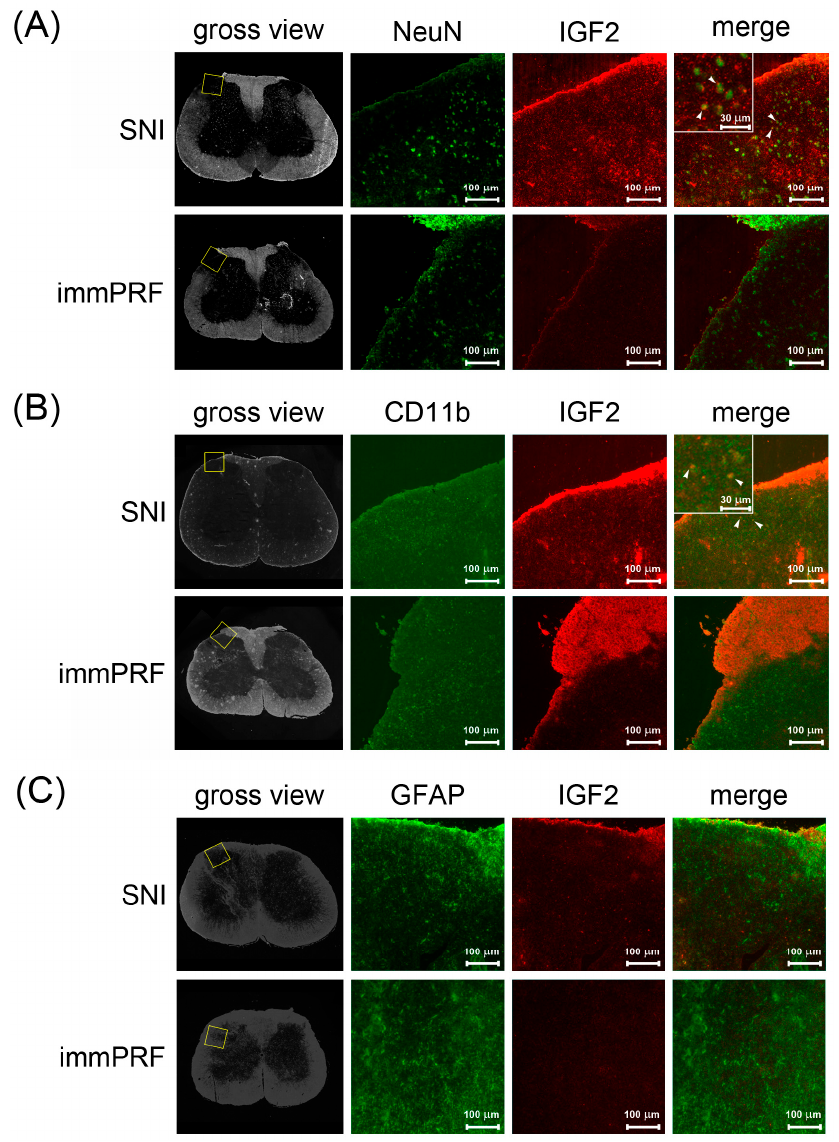
Figure 5. Identification of IGF2-expressing cells in the spinal cords of rats with SNI or SNI + immPRF treatment. ( A ) In situ immunofluorescent staining of NeuN and IGF2; ( B ) in situ immunofluorescent staining of Cd11b and IGF2; and ( C ) In situ immunofluorescent staining of GFAP and IGF2. The blank square in the gross anatomical views indicates the dorsal horn region used to illustrate the positive signals. All the gross views were taken by visible light. White arrowheads indicate merged signals. Green: NeuN, Cd11b, or GFAP. Red: IGF2. Scale bars = 100 μ m.